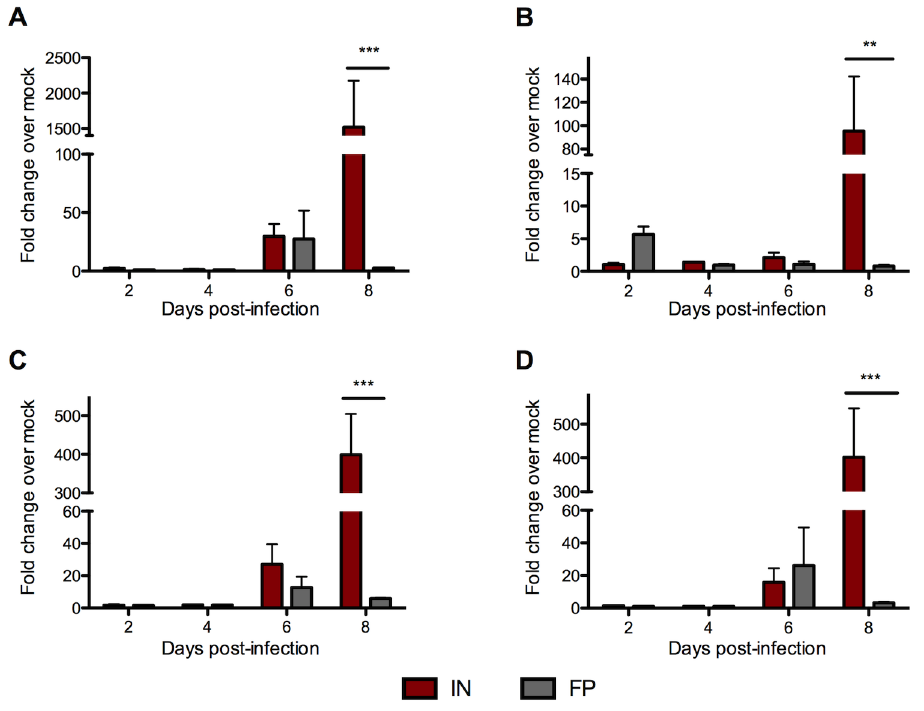
Figure 8. IN-inoculated mice displayed a strong proinflammatory cytokine response in the brain 8 dpi. Gene expression of several proinflammatory cytokines in the cerebrum of IN- and FP-inoculated mice was quantified by qRT-PCR, including (A) CCL2, (B) CCL5, (C) IL-6, and (D) TNF a . A housekeeping gene (GAPDH) was used to normalize gene expression data between all samples. Relative fold change was calculated by comparing expression in infected (IN or FP) tissues with mock-infected samples. Means based on groups of 5 mice per time point.